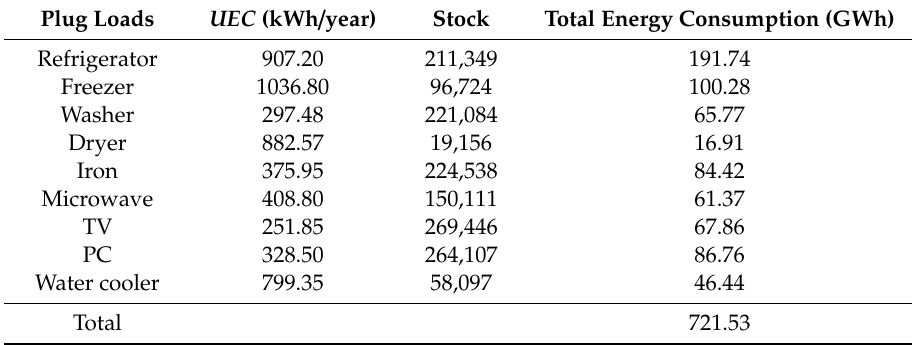
Table 7. The 2017 total energy consumption of modeled household appliances with corresponding stock quantities for expatriate (non-Kuwaiti) residential homes in